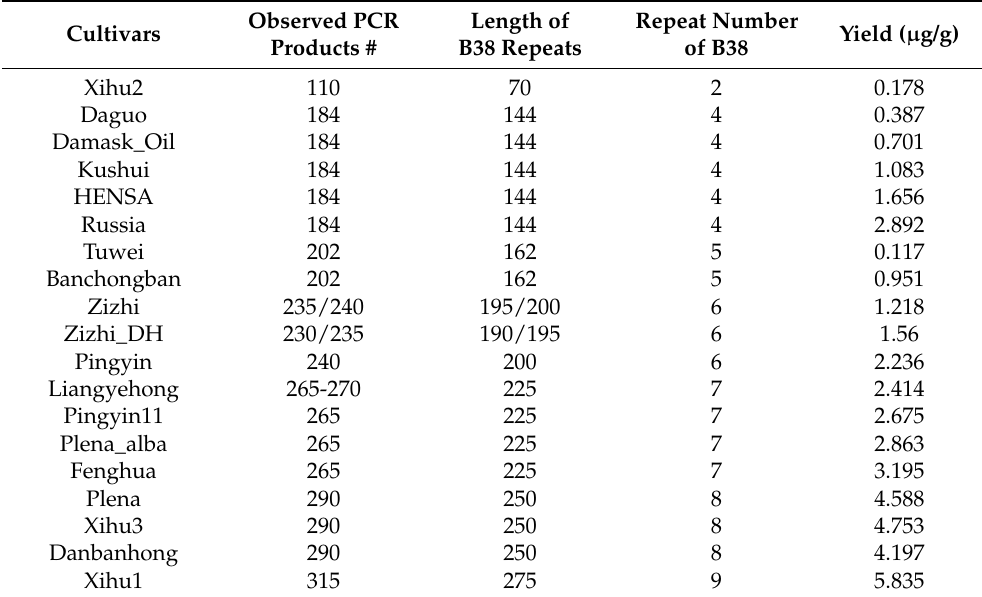
Table 1. B38 repeats polymorphism and oil yield of oil bearing roses.